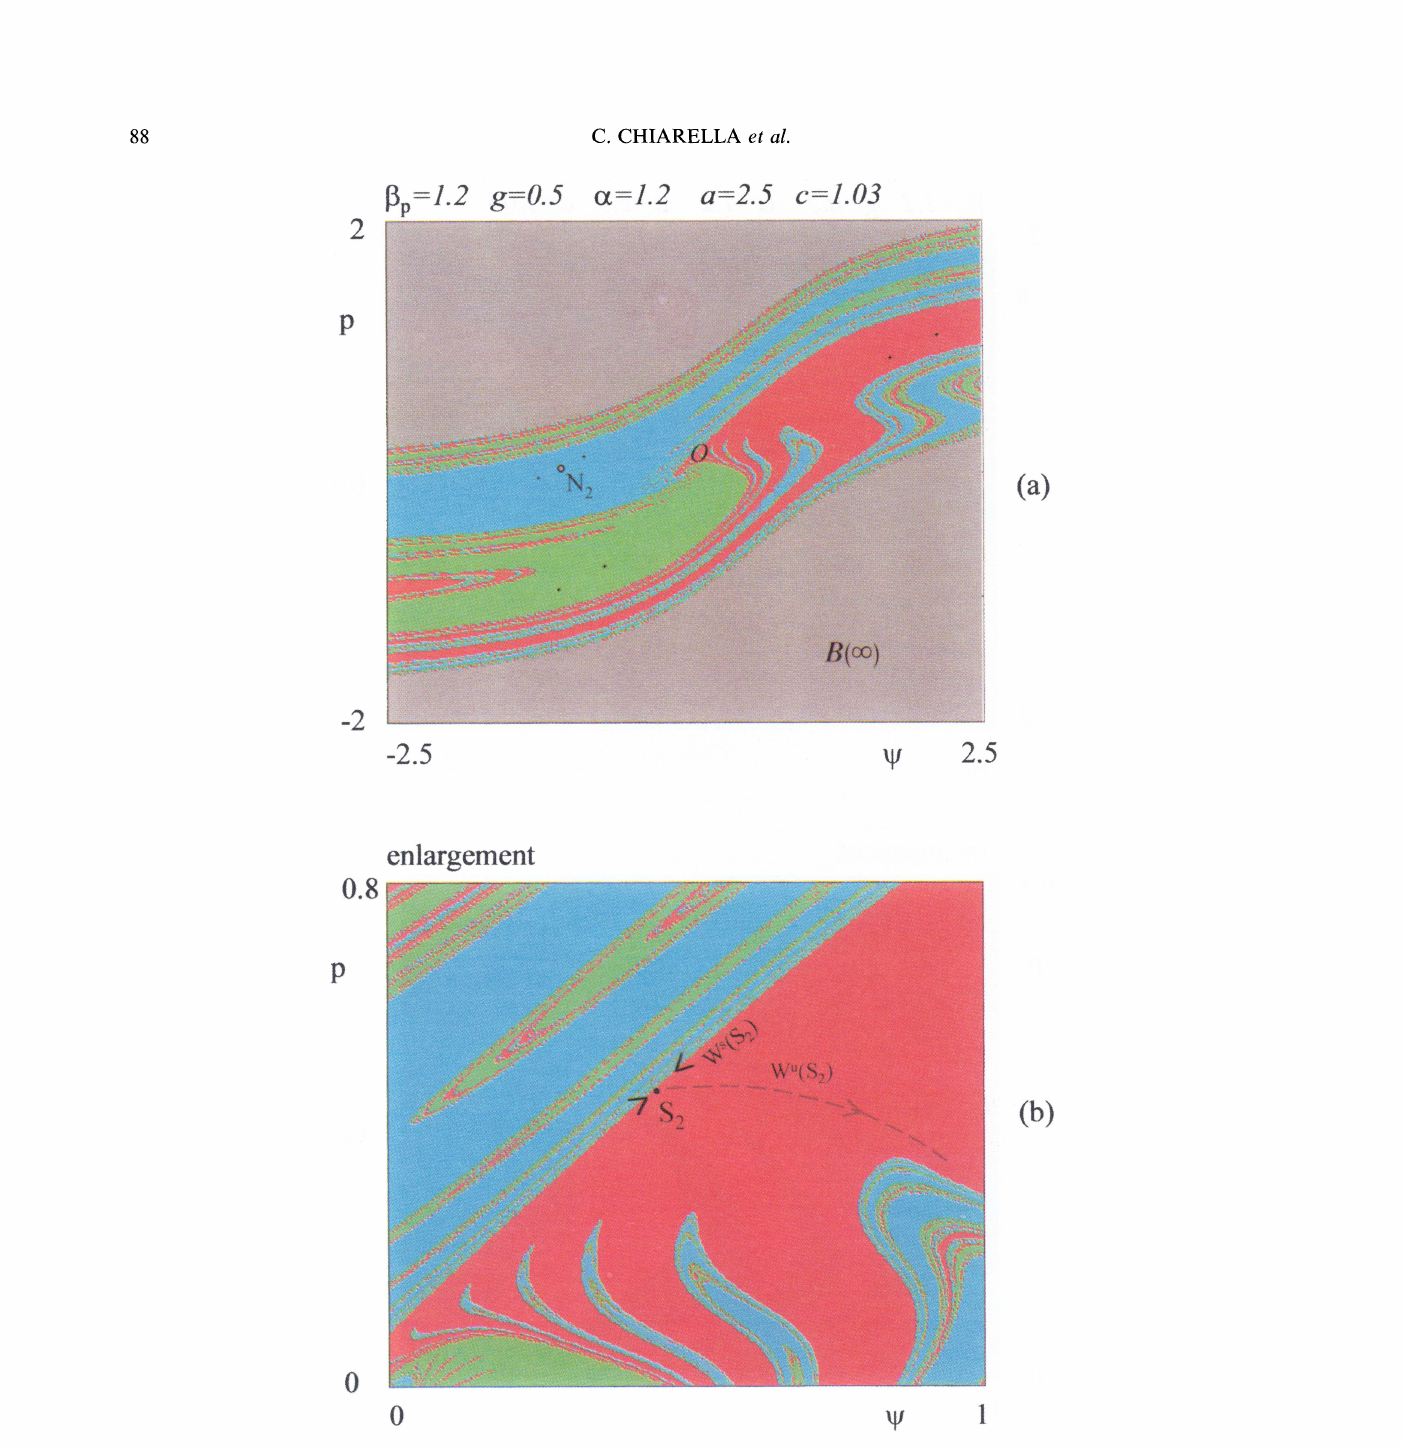
FIGURE 11 An example of the route to fractal basins, observed in the same regime of parameters considered in Figures 7-9, i.e., p= 1.2, g--0.5, c= 1.2, a=2.5, and for values of c > 1, in the region of invertibility of the map T. For e= 1.03 the attracting sets of the map T are three cycles of period-2, flip-bifurcated from the three fixed points represented in Figure 9, whose basins are represented with different colours in (a). The enlargement in (b) shows that the "tongues" of the basins, bounded by the stable set Ws(S2) of the saddle $2 are approaching one branch of the unstable set, Wu(S2). At a value of e in the interval (1.04, 1.05) the homoclinic tangency between Ws(S2) and Wu(S) occurs, followed by a transverse intersection, as shown in (c) and (d), obtained for c 1.05. This homoclinic bifurcation gives rise to the characteristic "tangle" in the neighbourhood of the saddle. (See Color Plate